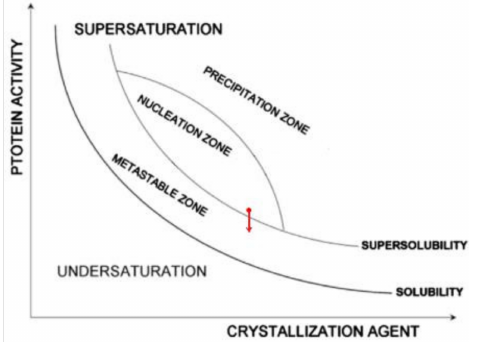
Figure 6. Ostwald–Miers phase diagram [17] illustrating the nucleation of a protein crystal in a pore (see the red point close to the super-solubility curve showing its presumable place in the nucleation zone where nucleation occurs), while, most probably, the crystal grows outside the pore orifice in the metastable zone, which is shown by the red arrow.